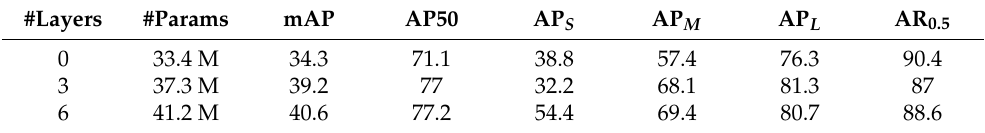
Table 9. Ablation analysis for encoder size. Performance gradually improves with more encoder layers.